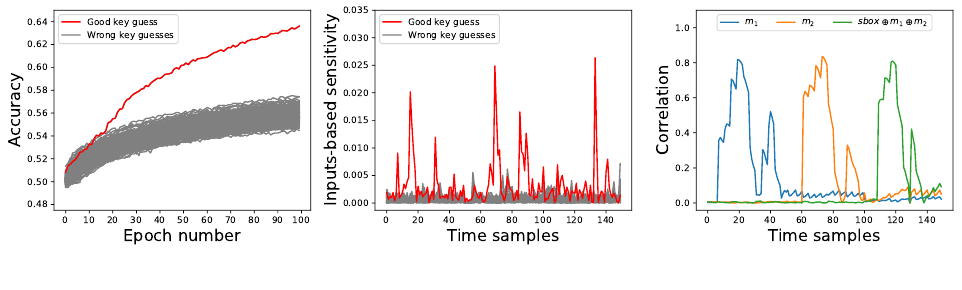
Figure 12: DDLA on CW 2-masks protected implementation. Left: Accuracy. Center: Inputs-based sensitivity. Right: CPA-based reverse